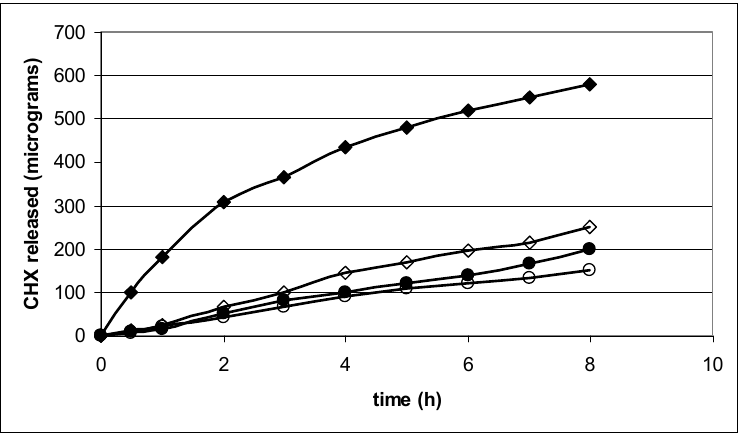
Figure 5. Release profile of CHX from Gels: 1 ♦ ; 5 ◊ ; 6 ● ; 8 ○ , using a modified Franz